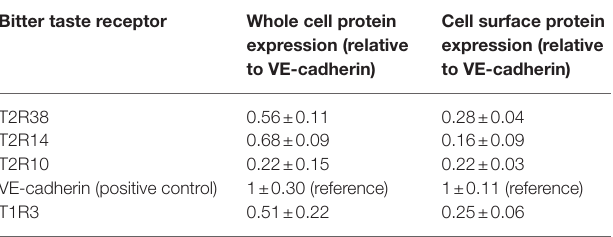
TABLE 3 | Protein expression levels of bitter taste receptors in human pulmonary endothelial cells. Bitter taste receptor Whole cell protein expression